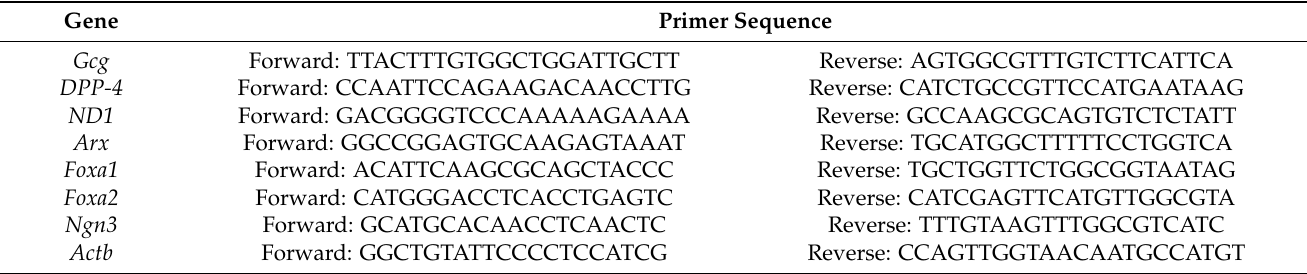
Table 1. Primers used for Real-time